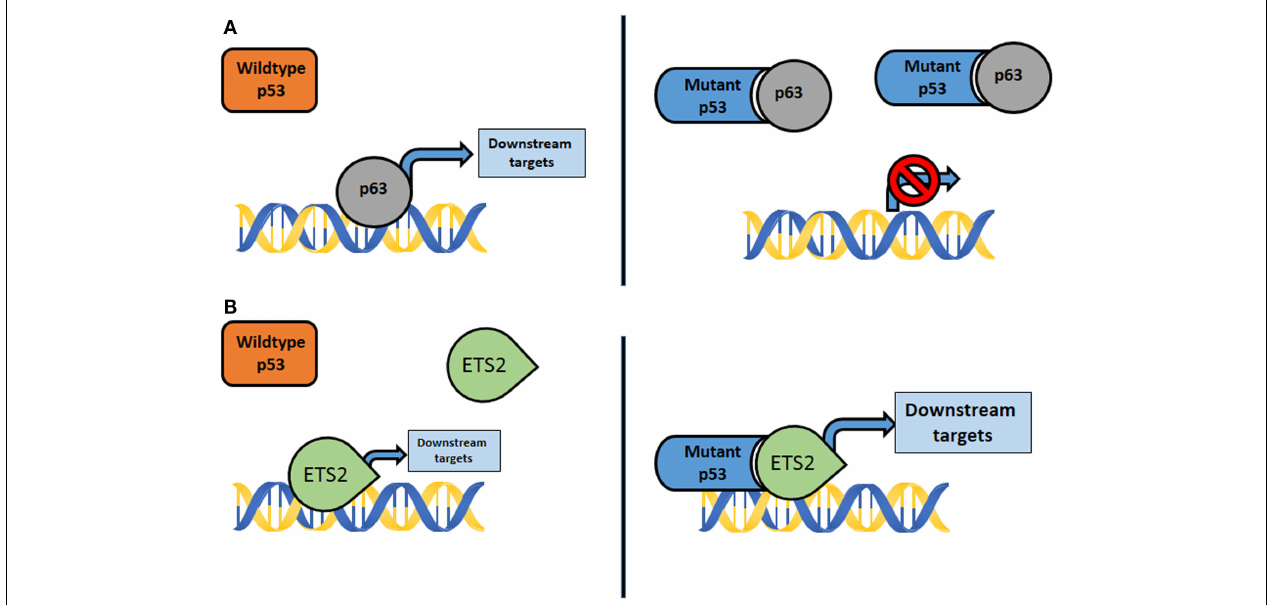
FIGURE 1 | (A) Mutant p53 interacts with transcription factors not normally bound by wildtype p53 , such as p63 , p73 , and Smad . The activity of downstream targets is disrupted, resulting in GOF properties. (B) Mutant p53 complexes with transcription factors, such as Ets2 and SREBP , not typically bound by wildtype p53 . The results are aberrant activation of genes and downstream effectors that promote GOF